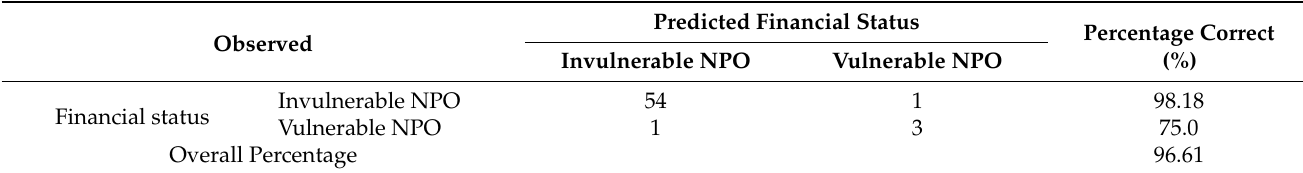
Table 11. Classification table based on the test sample a .